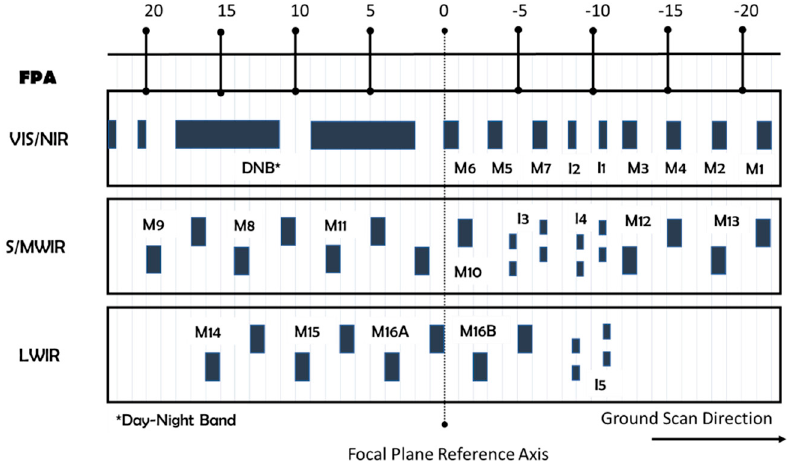
Figure 1. VIIRS FPAs: VIS/NIR, S/ MWIR, and LWIR. The VIIRS band layout is in the scan direction. The M- and I-bands have 16 and 32 detectors in the track direction, respectively. Values at the top of the figure represent each band’s position in M-band sampling interval units relative to the focal plane reference axis. These values also define the relative number of samples removed at the EV beginning-of-scan for alignment. The Day-Night Band illustrates four detector arrays in three gain stages and is not to scale.